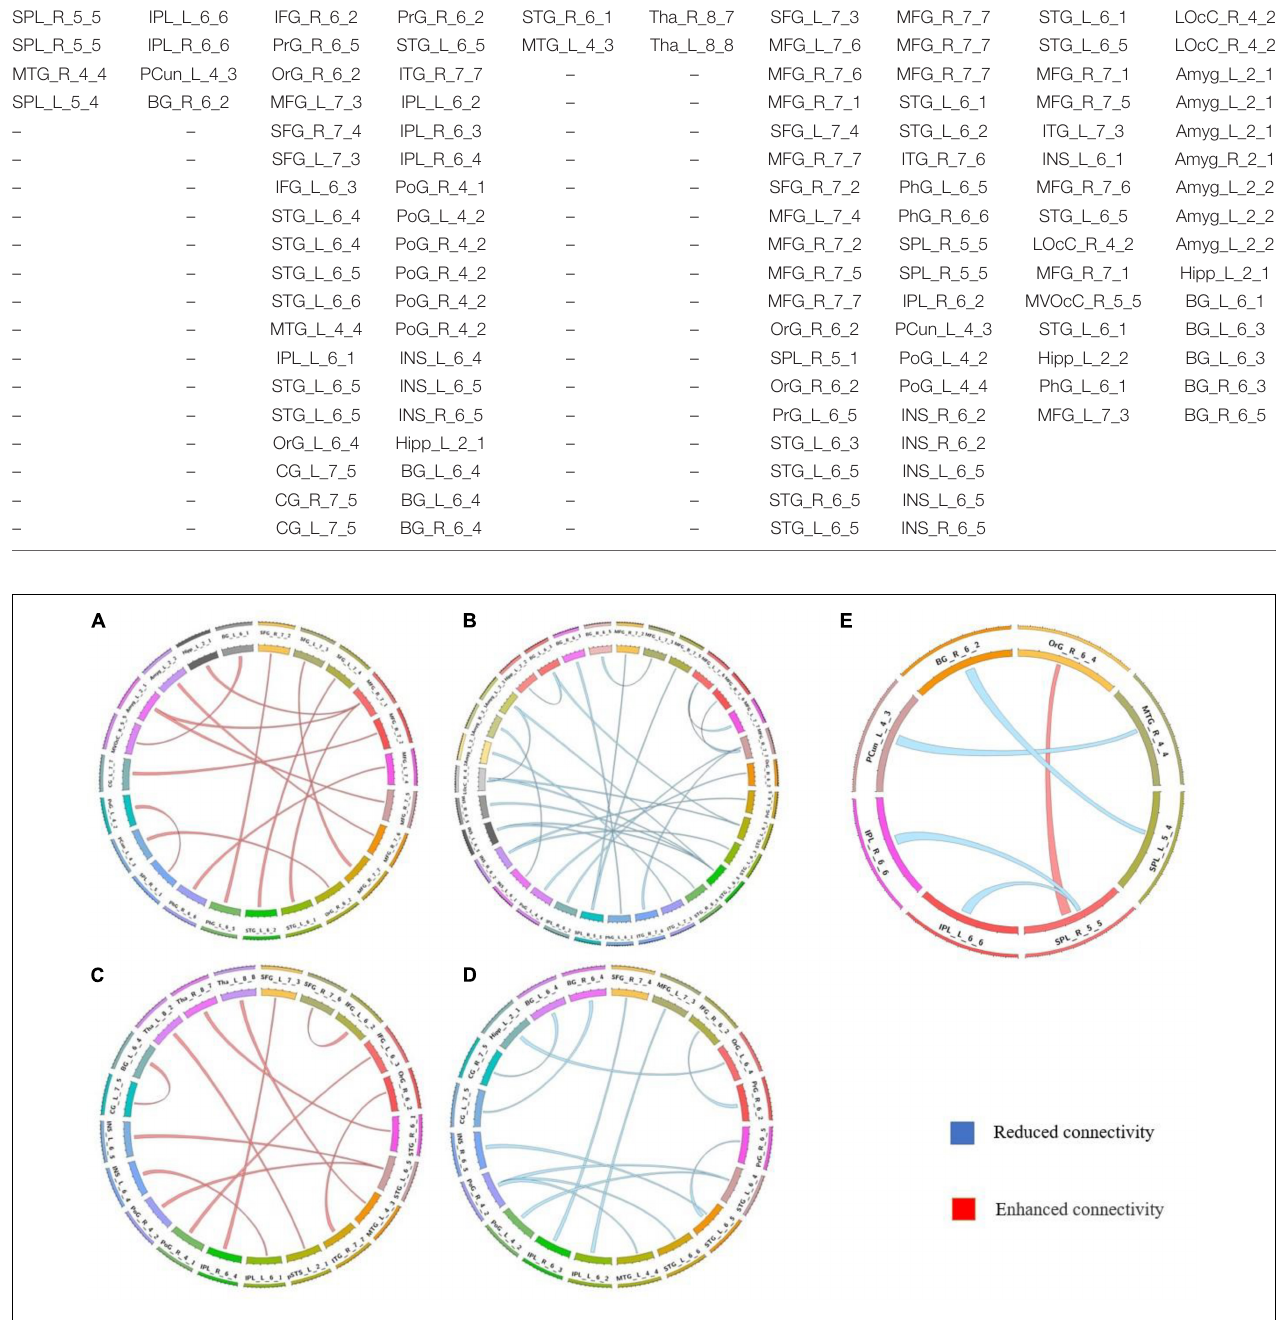
FIGURE 2 | Comparison of the static functional connectivity of the three groups after global signal regression. (A) Static functional connections with enhanced connectivity in the non-AVHs group compared with the NC group; (B) Static functional connections with reduced connectivity in the non-AVHs group compared to the NC group; (C) Static connections with enhanced connectivity in AVHs group compared with NC group; (D) Static connections with reduced connectivity in AVHs group compared with NC group; (E) Compared with non-AVHs group, static connections with significant differences in AVHs group. Red represents increased connectivity and blue represents decreased